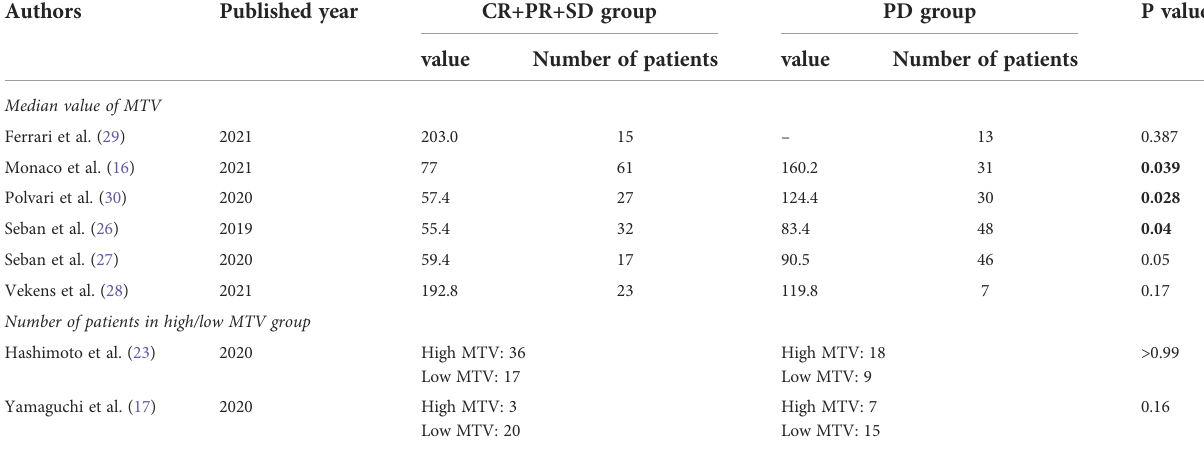
TABLE 2 MTV values and objective response (RECIST